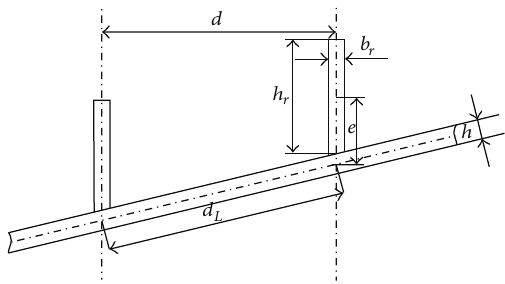
Figure 2: The parameters of the